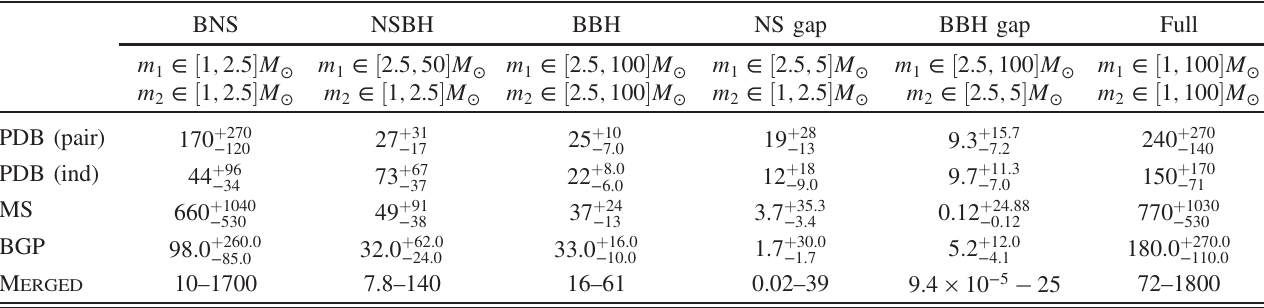
TABLE II. Merger rates in Gpc − 3 yr − 1 for the various mass bins, assuming merger rates per unit comoving volume are redshift independent. BNS, NSBH, and BBH regions are based solely upon component masses, with the split between the NS and BH taken to be 2 . 5 M ⊙ . We also provide rates for binaries with one component in the purported mass gap between 2.5 and 5 M ⊙ . For all but the last row, merger rates are quoted at the 90% credible interval. For the last row, we provide the union of 90% credible intervals for the preceding three rows, as our most conservative realistic estimate of the merger rate for each class accounting for model systematics. The PDB (pair) model is distinct from the other three models due to its use of a pairing function [161] and is therefore excluded from the union of credible intervals in the final row. In Sec. VI we estimate the merger rate for BBHs alone, accounting for variation in merger rate versus